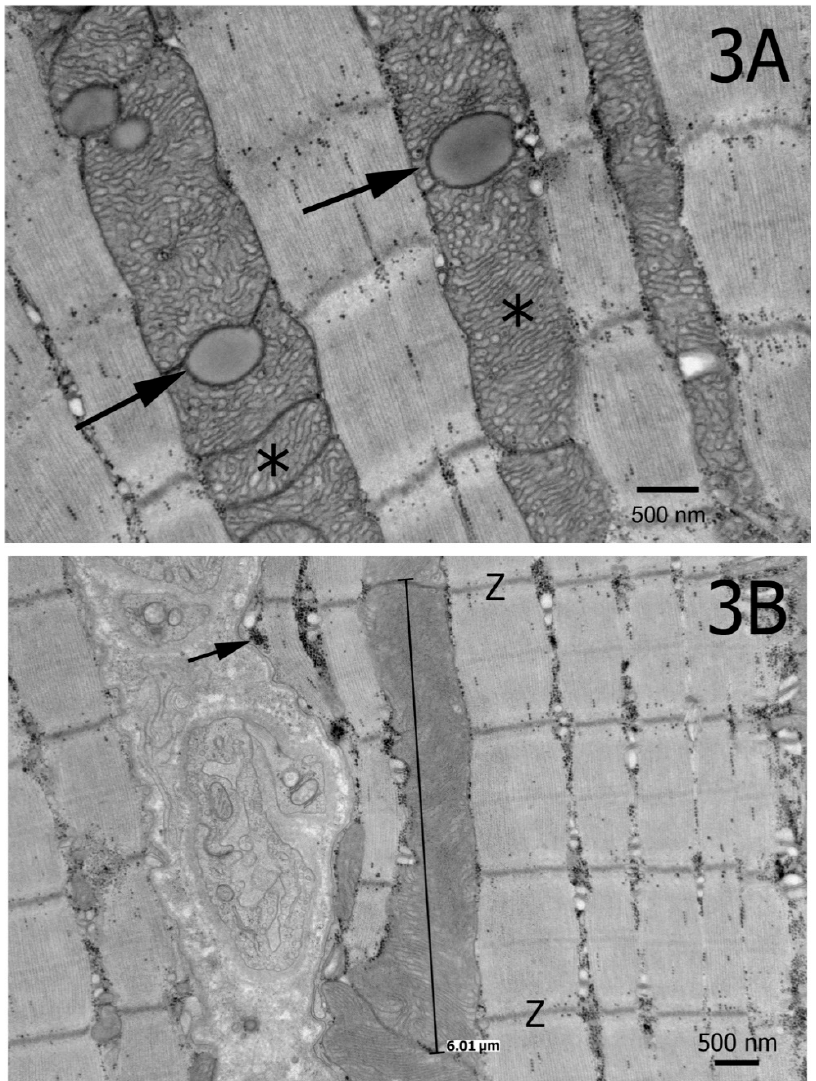
Figure 3. ( A ) Electron micrograph showing hyperplastic mitochondria with irregular cristae (*). Arrows highlight lipid bodies. ( B ) A large mitochondrion spans over 3 sarcomeres. Membrane proliferation in swirls and electron dense inclusions (arrow) were also noted. Z = z lines.